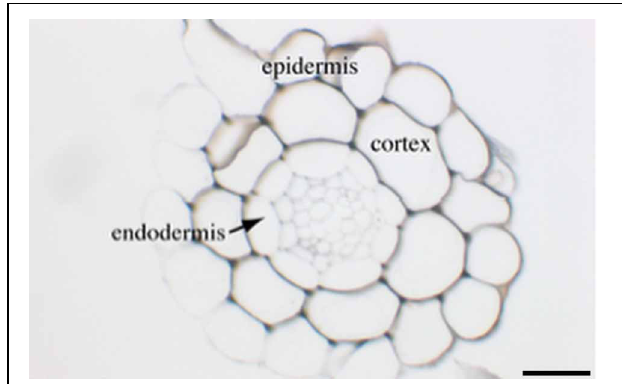
FIGURE A1 | Iron detection in Arabidopsis roots from plants grown in plate. Three-week old wild-type plants grown in MS/2 medium supplemented with 50 µ M Fe-EDTA were embedded in Technovit resin and the sections were stained with Perls/DAB. The scale bar represents 50 µ